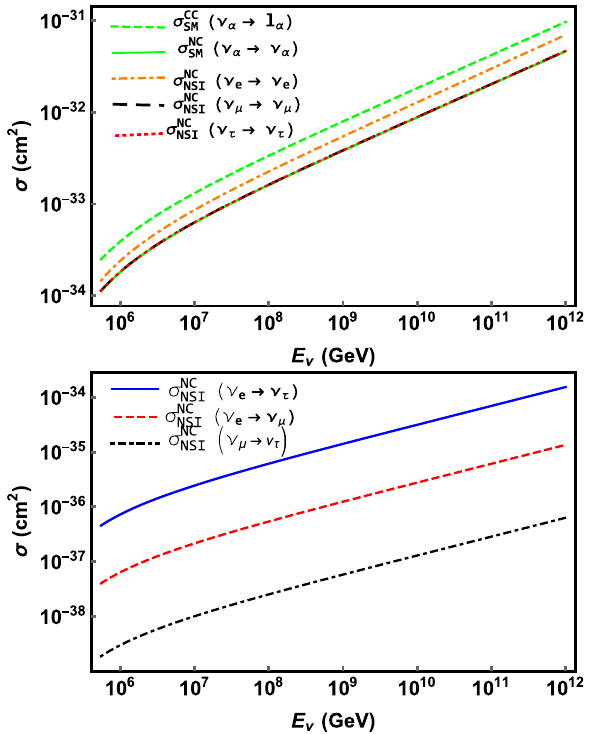
Fig. 2 Variation of scattering cross sections ( σ ) in CC and NC pro- cesses. Top panel: For CC and NC flavour diagonal processes (NC includes both SM and NSI); bottom panel: For flavour non-diagonal processes in case of NC interactions (with NSI) Table 1 Values of NSI parameters from COHERENT experiment in 2 σ range including the information of both the time and energy [12]. , A The contributions of ε s , V αβ is zero, as well as ε f αβ for all the three quarks